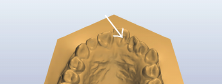
Figure 2: Clinical appearance of fused tooth; intraoral palatinal view.